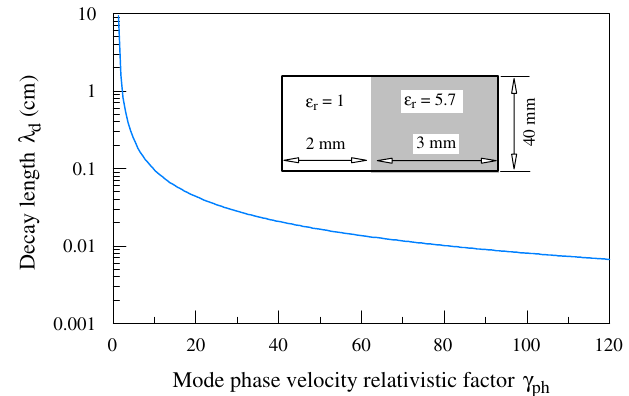
FIG. 3. (Color) Dependence of decay length (cid:4) on relativistic d for imaginary mode LSM in a two-zone rectangular factor (cid:5) ph 11 DLW structure, of which the width is 5 mm and the height is (cid:4) 1 , " (cid:4) 5 : 7 , and (cid:1) (cid:4) (cid:1) (cid:4) 1 40 mm, with " r 1 r 2 r 1 r 2